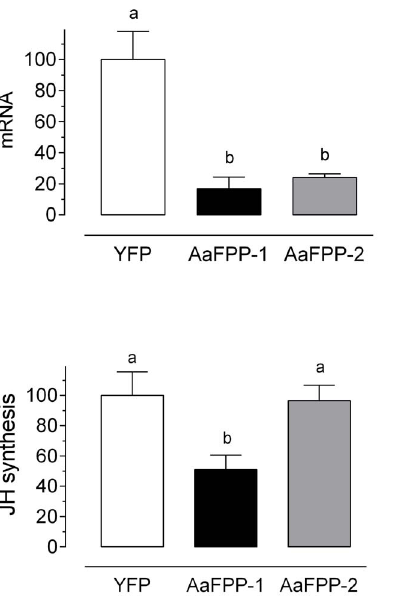
Figure 7. dsRNA mediated knockdown of Aa FPPase-1 and -2. Newly emerged female mosquitoes were injected with ds Aa FPPase-1, ds Aa FPPase-2 or dsYFP; 4 days later transcript and JH levels were evaluated. A) Transcript levels are expressed as % of the YFP controls. Bars represent the means 6 S.E.M. of two replicates of RNA extracted from thoraxes. B) JH synthesized in vitro : CA were dissected from females injected with ds Aa FPPase-1, ds Aa FPPase-2 or YFP dsRNA and incubated in vitro for 4 h. JH was evaluated by HLPC-FD. Bars represent the means 6 S.E.M. of four replicates of 4 CA. Different letters above the columns indicate significant differences among treatments (one way ANOVA p , 0.05, with Tukey’s test of multiple comparisons).